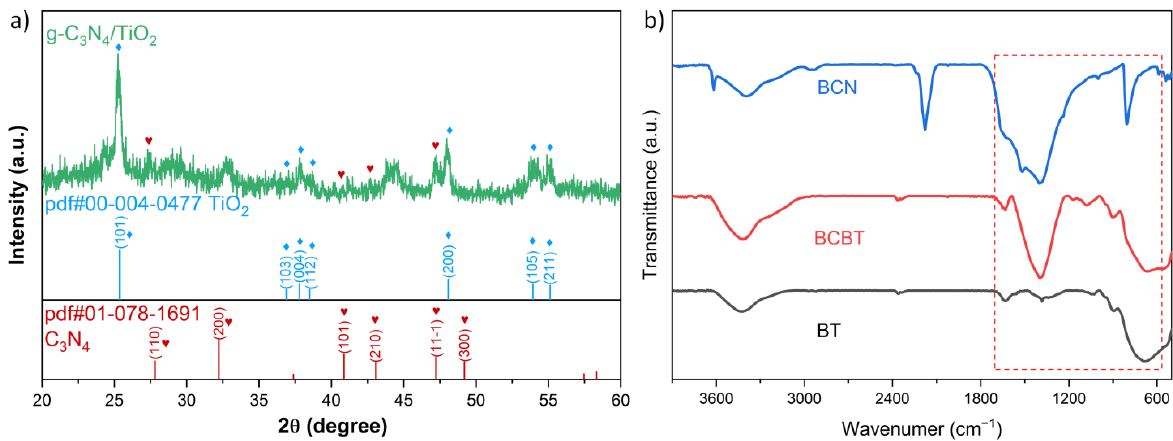
Figure 1. The XRD patterns of BCBT photocatalysts (TiO 2 in blue, C 3 N 4 in red) ( a ) and FT-IR spectra of all prepared photocatalysts ( b ). of all prepared photocatalysts ( b